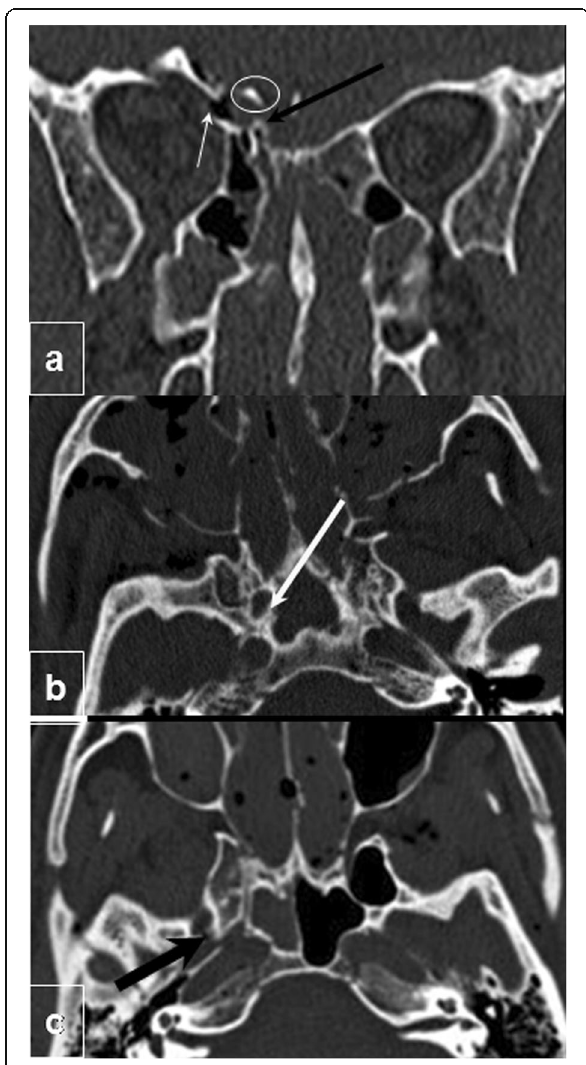
Fig. 6 Skull base extension. a Anterior cranial fossa: coronal CT image shows a fracture extending to the lamina cribrosa, communicating the ethmoid cells with the anterior fossa of the cranium on the right side (black arrow) and spanning the orbital roof (white arrow). There is a small intracranial bone fragment (circled). This fracture may cause cerebrospinal fluid rhinorrhea and even infectious intracranial complications. b , c Middle cranial fossa axial CT images from two different patients show extension of the fracture into the sphenoid bone and skull base affecting the carotid canal (white arrow in b ) and foramen ovale (black arrow in c ) with possible injury to carotid arteries and cranial